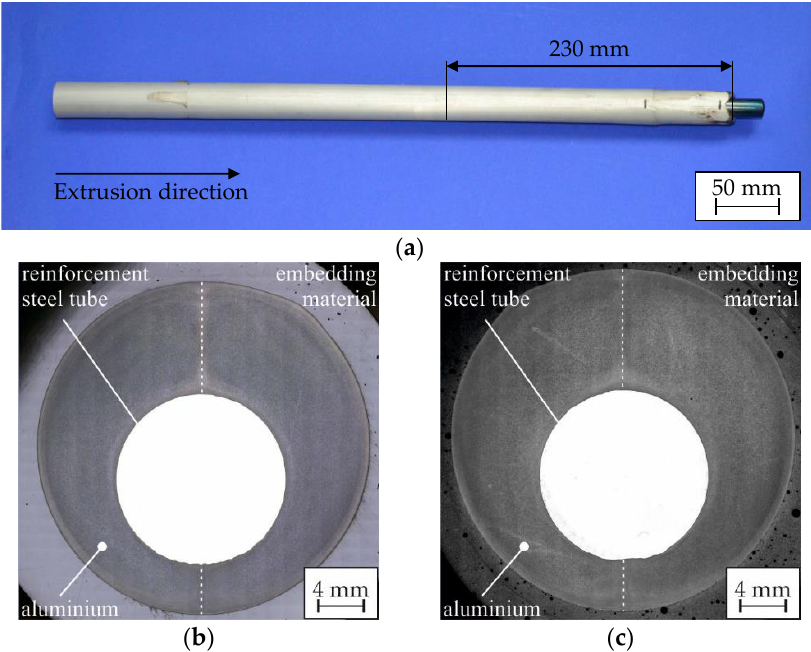
Figure 3. Hybrid aluminum-steel compounds co-extruded at 480 °C: ( a ) Overview image; ( b ) Metallographic image of the cross-section after a profile length of 230 mm for a ram speed of 2 mm·s −1 ; ( c ) Metallographic cross-section after a profile length of 230 mm for a ram speed of 4 mm·s −1 .